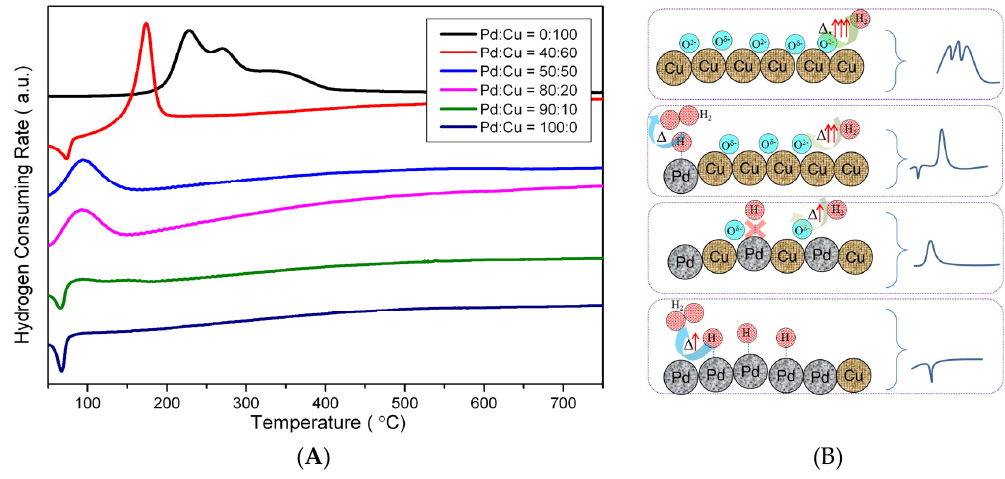
Figure 2. ( A ) H 2 ‐ TPR patterns for catalysts of 1 wt % Pd ‐ Cu/Al 2 O 3 with different Pd/Cu ratios; and ( B ) illustrations of hydrogen adsorption/desorption on the PdCu surface corresponding to the peak characteristics in ( A ).